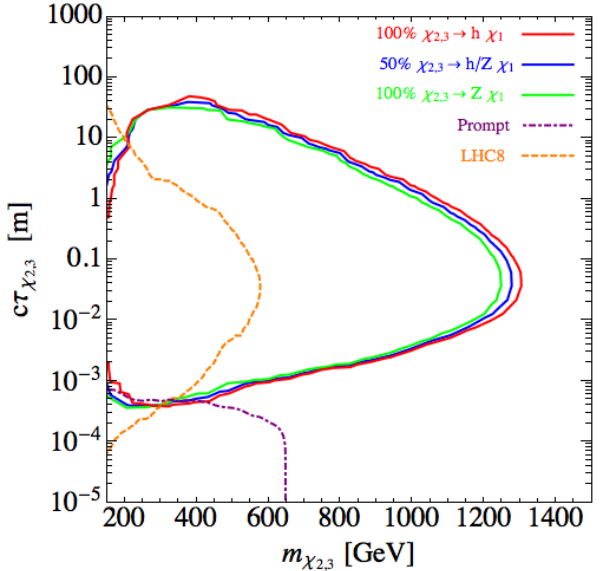
Figure 10 . Estimated exclusion curves from collider searches in the plane of the decay length versus the mass of the heavy neutral fermions. Our recasting of the ATLAS DV+ E / search, T associated to the (cid:12)nal states of hh + E / , hZ + E / or ZZ + E / , for the simpli(cid:12)ed models i), ii) and T T T iii) (see the text for details) are shown with red, blue and green solid lines respectively. The orange dashed line is the exclusion of displaced searches at 8 TeV LHC, as estimated in [105]. The purple dashed-dotted line is our estimate of the impact of the prompt searches at 13 TeV performed by CMS